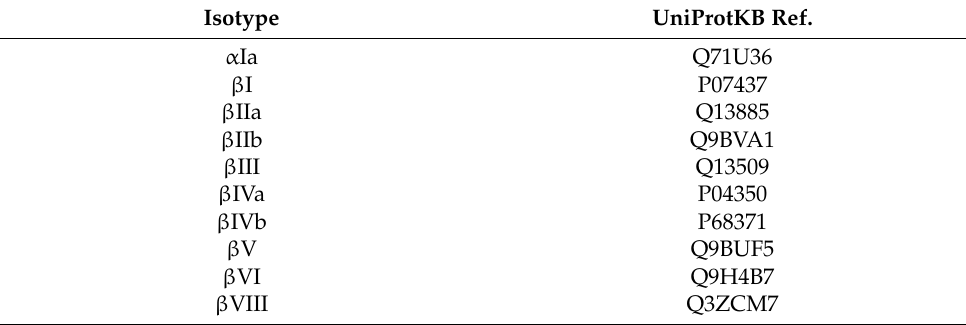
Table 2. UniProtKB references of the human tubulin target sequences for homology